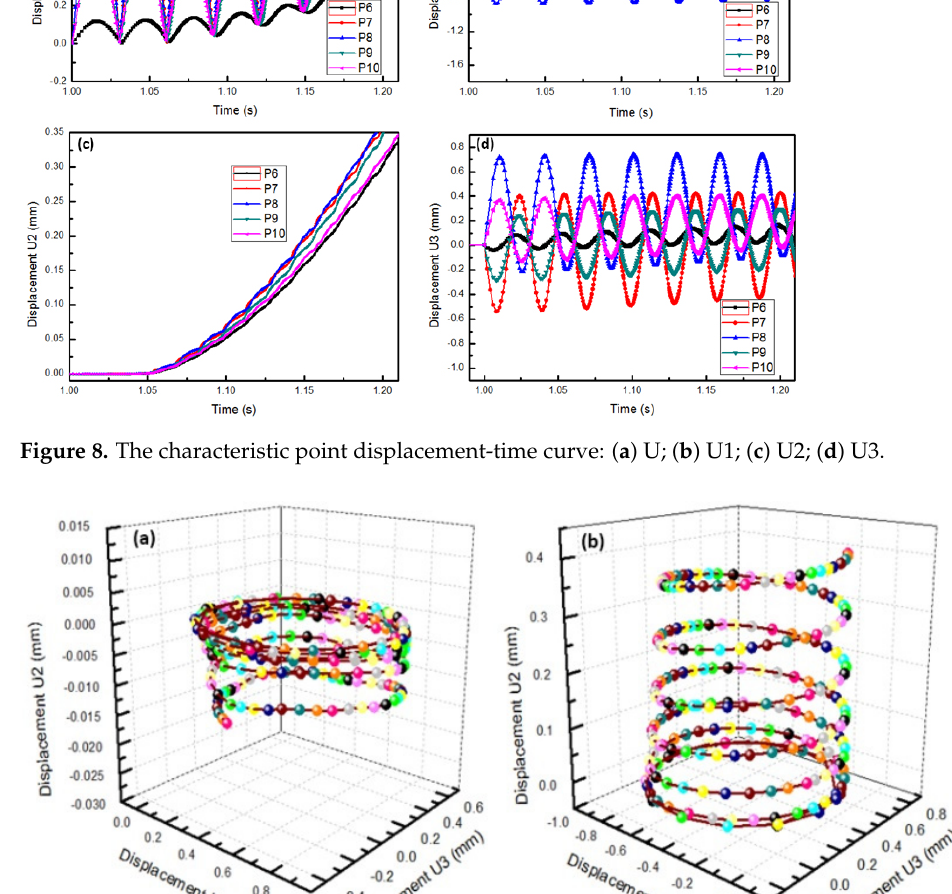
Figure 10. ( a , c ) Strain and stress distribution and ( b , d ) polycrystalline model. The simulation of thread rolling is more complicated than the uniaxial tension and compression process. As the workpiece rotates, the stress state will change periodically. When polycrystalline materials are formed, there is a big difference in the deformation